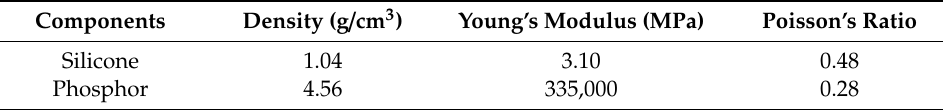
Table 2. FEA simulation parameters.